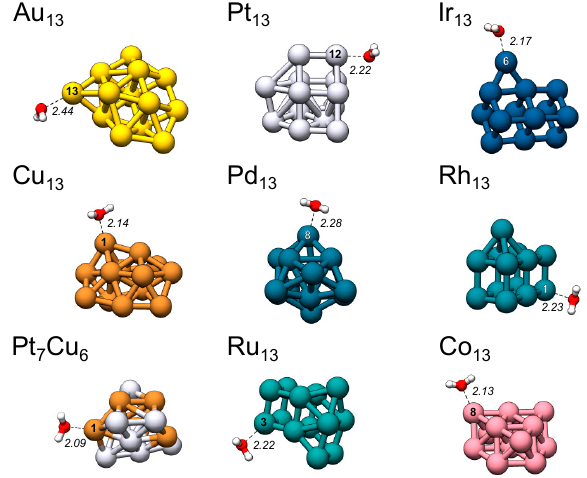
Figure 5. All TM 13 nanoparticles with H 2 O adsorbed at the favored position. Interaction distances are given in Å. Refer to the supplementary material for information on the remaining structures (Section S6 and Table S4).